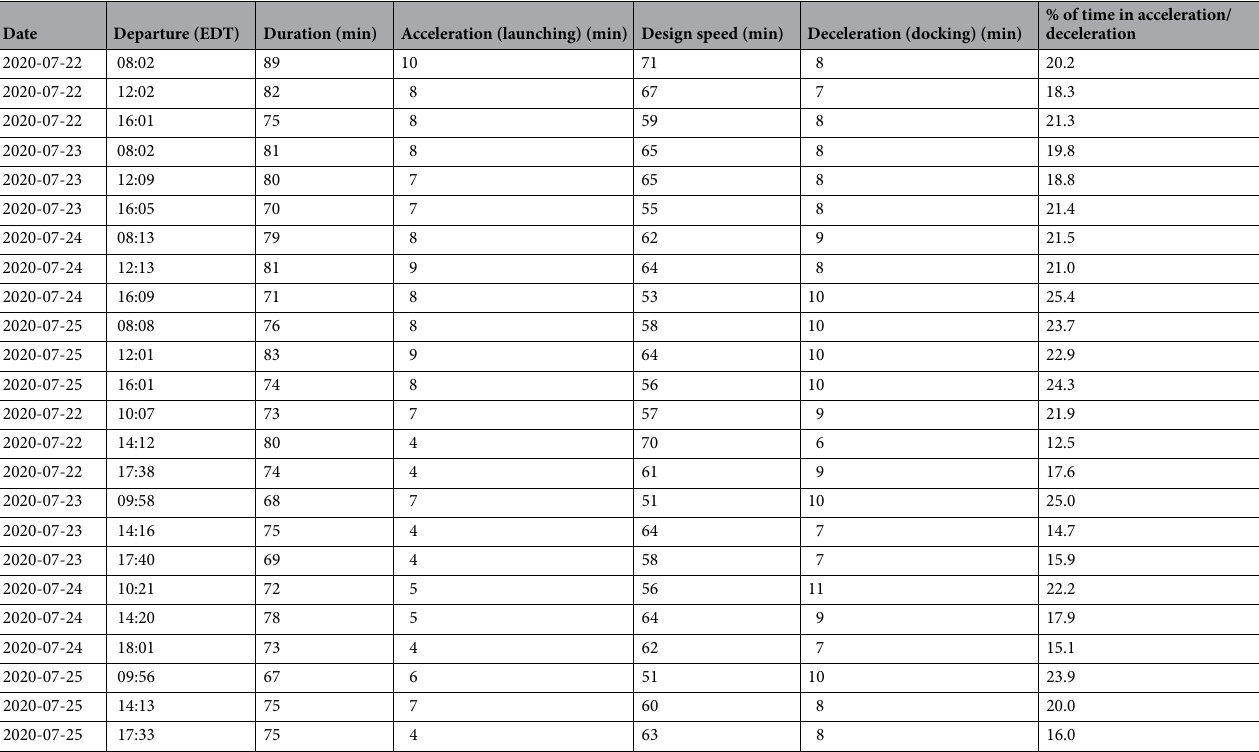
Table 2. Time division of standard N.M. Trans-Saint-Laurent’s Trips.